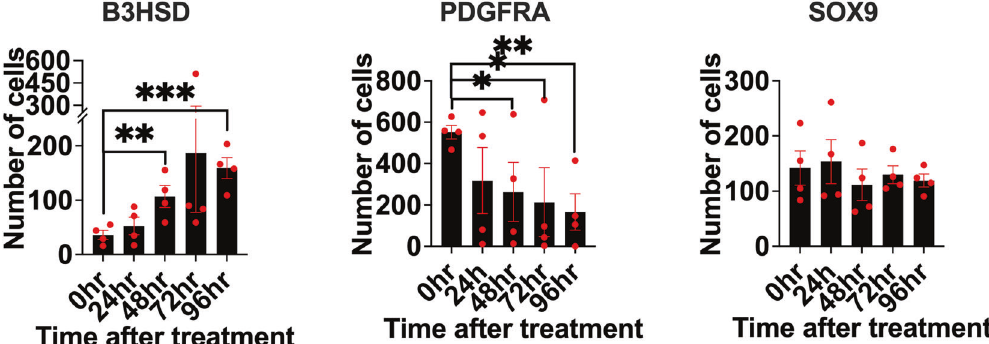
Fig. 6 Leptin regulates LSC differentiation. Flow cytometry analysis showing the effects of increased concentration of leptin ranging from 0, 1, and 10 ng/ml on the percentage of Leydig cells, Sertoli cells, and peritubular myoid cells for 24, 48, 72, and 96 h, respectively. Asterisks denote p values (e.g., * p < 0.05, **** p <